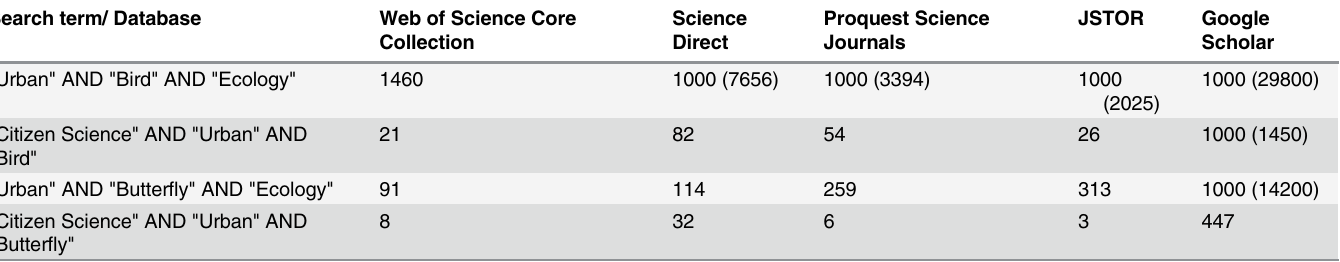
Table 1. Search terms, databases and respective article yield applied for this literature review. Numbers in brackets indicate the total number of arti- cles returned, compared to the number available for review (maximum 1000, except for Web of Science) in every case. Search term/